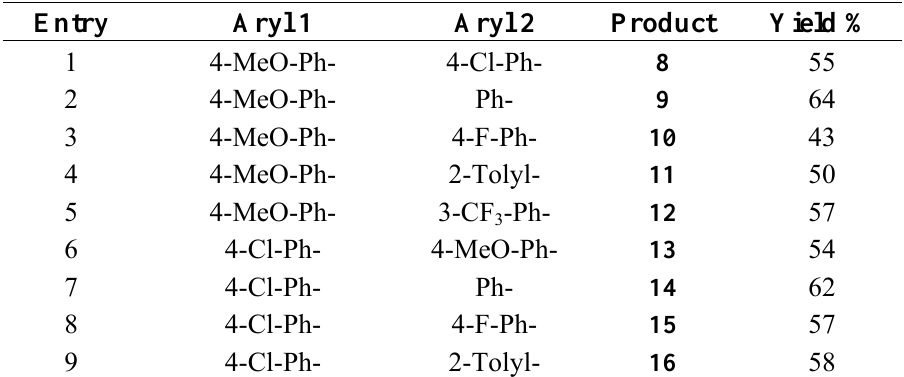
Table 3. Suzuki-Miyaura reactions between monosubstituted products 6a or 6b and various arylboronic